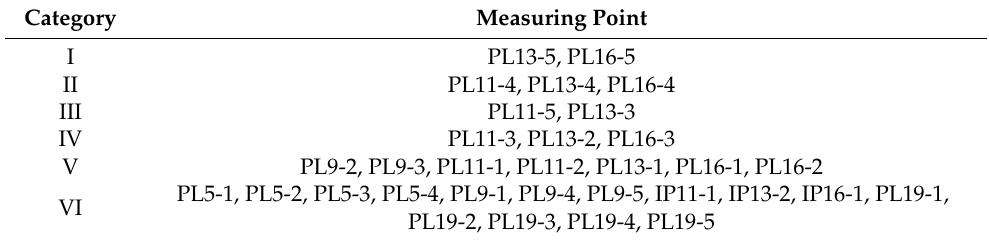
Table 1. Zoning results of deformation measuring points of the ultra-high arch dam during the first phase.